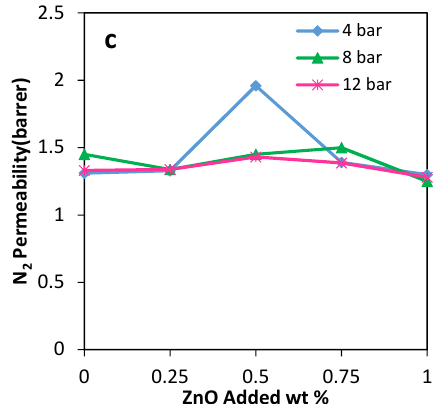
Figure 5. ( a ) CO 2 ; ( b ) CH 4 and ( c ) N 2 permeabilities through the MMMs vs. ZnO nanoparticles loading in PU. Table 4. Pure gas permeabilities of the MMMs at different pressures.